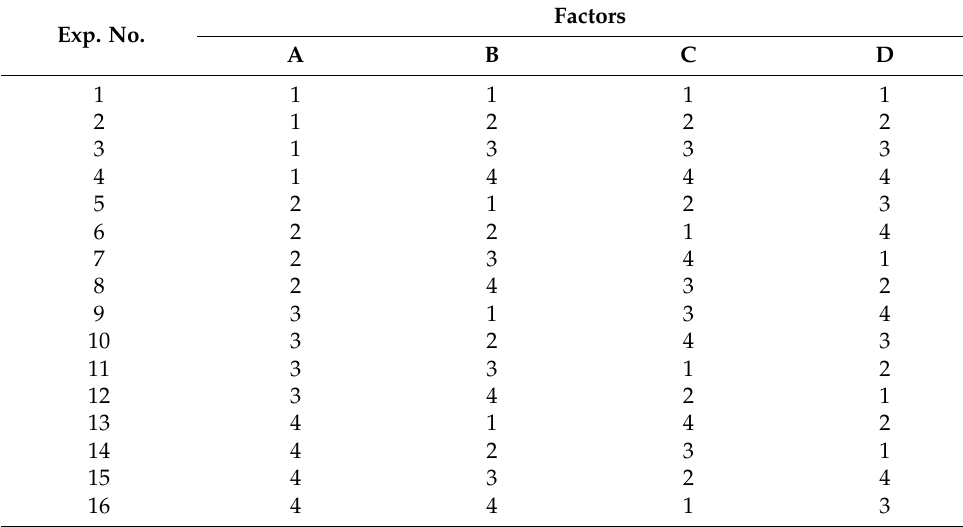
Table 6. L16 orthogonal array for Cl removal by